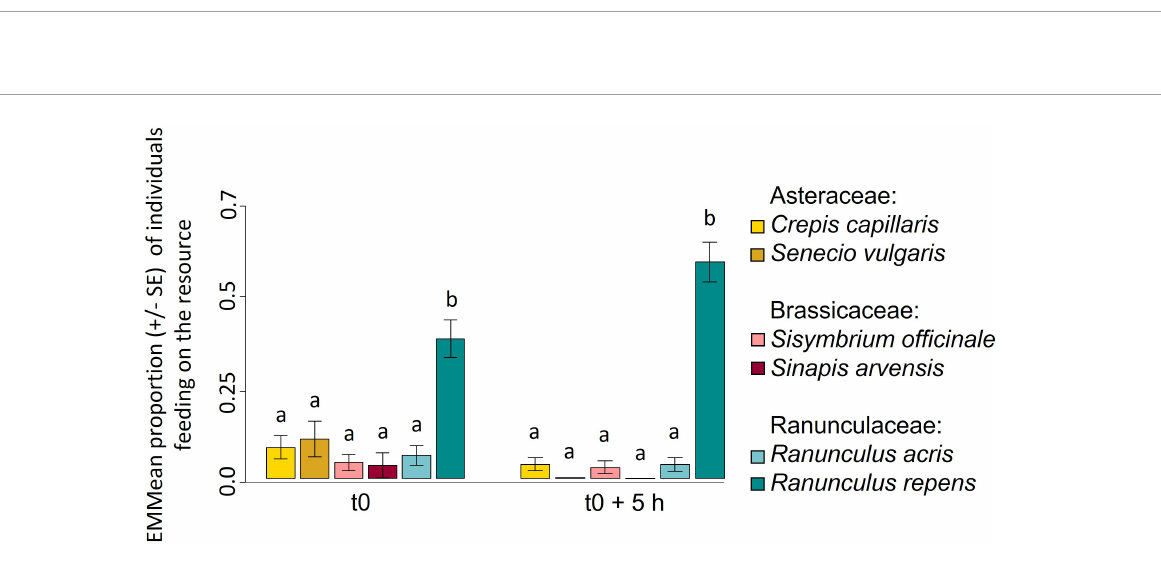
FIGURE5 The proportion of pollen beetles feeding on artificial diets containing macronutrients in the same concentrations as found in anthers from Ranunculus repens increases over time. Estimated Marginal Mean (EMMean) proportion ( ± SE) of individuals feeding on each resource at the first and last record of the experiment. Different letters indicate significantly different EMMeans. n =